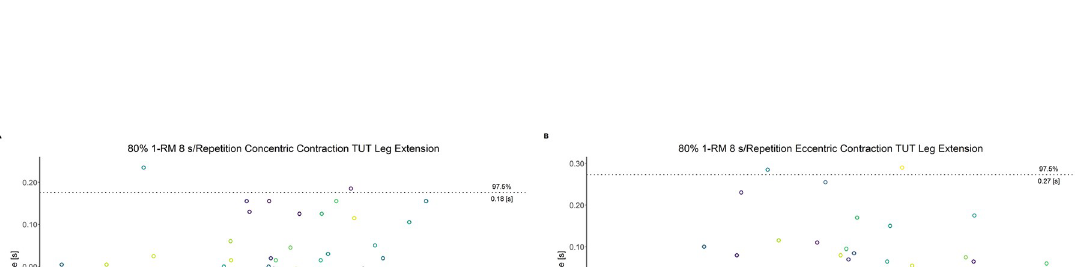
PLOS ONE | https://doi.org/10.1371/journal.pone.0254164 July 20, 2021 16 /